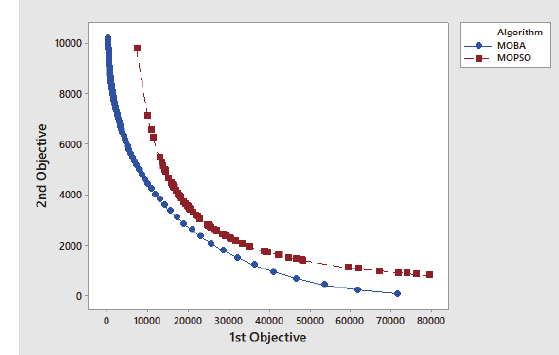
Fig. 8. Scatterplot of the performance of MOPSO & MOBA (WIP inventory model)